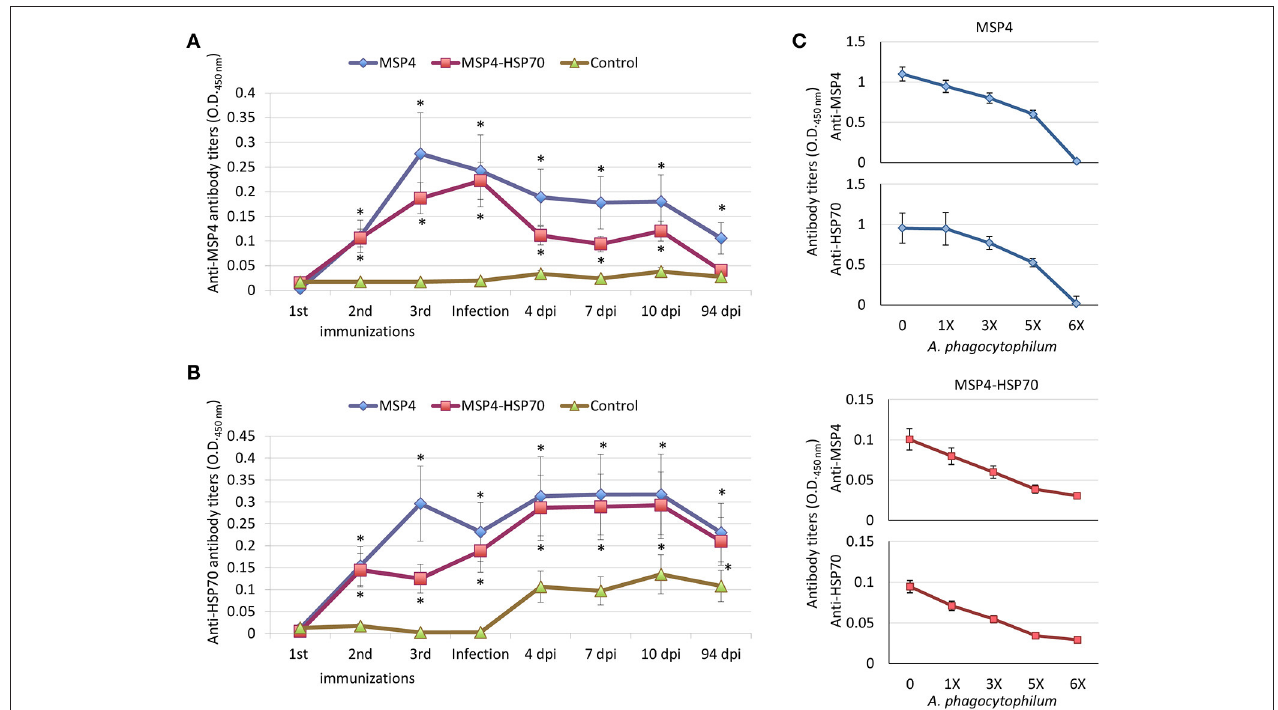
FIGURE 4 | Antibody response in lambs immunized with A. phagocytophilum MSP4 and MSP4-HSP70 proteins. Groups of three lambs each were immunized with recombinant MSP4, MSP4-HSP70 combination or adjuvant/saline control and experimentally infected with a sheep isolate of A. phagocytophilum . An indirect ELISA test was performed to detect IgG antibodies against (A) MSP4 and (B) HSP70 proteins in immunized and control lambs using serum samples collected before each immunization and at 0, 7, 10, and 94 dpi. Antibody titers were expressed as OD 450nm (OD lambsera − OD PBScontrol ). The results were compared between immunized and control groups by two-way ANOVA test (* P < 0.05; N = 3 replicates per treatment). (C) The antigen-specific IgG antibody response in immunized lambs was corroborated by ELISA using pooled sera collected at 0 dpi, but incubating sera with different concentrations of A. phagocytophilum purified from infected